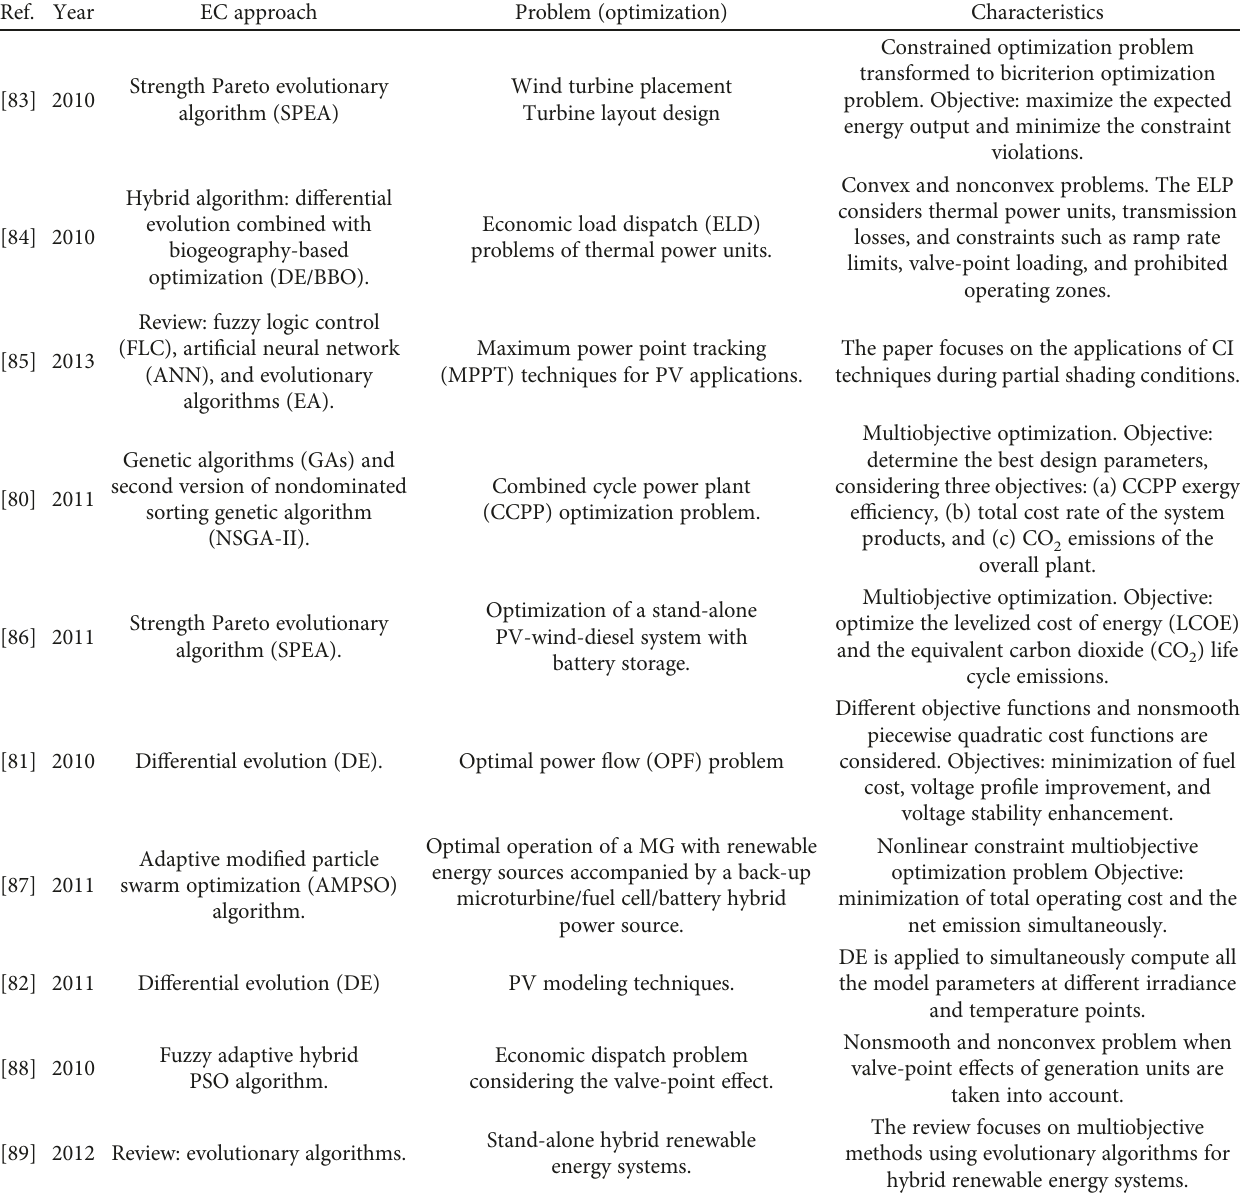
Table 4: Most cited papers between 2010 and 2017 of EC applied to energy-related